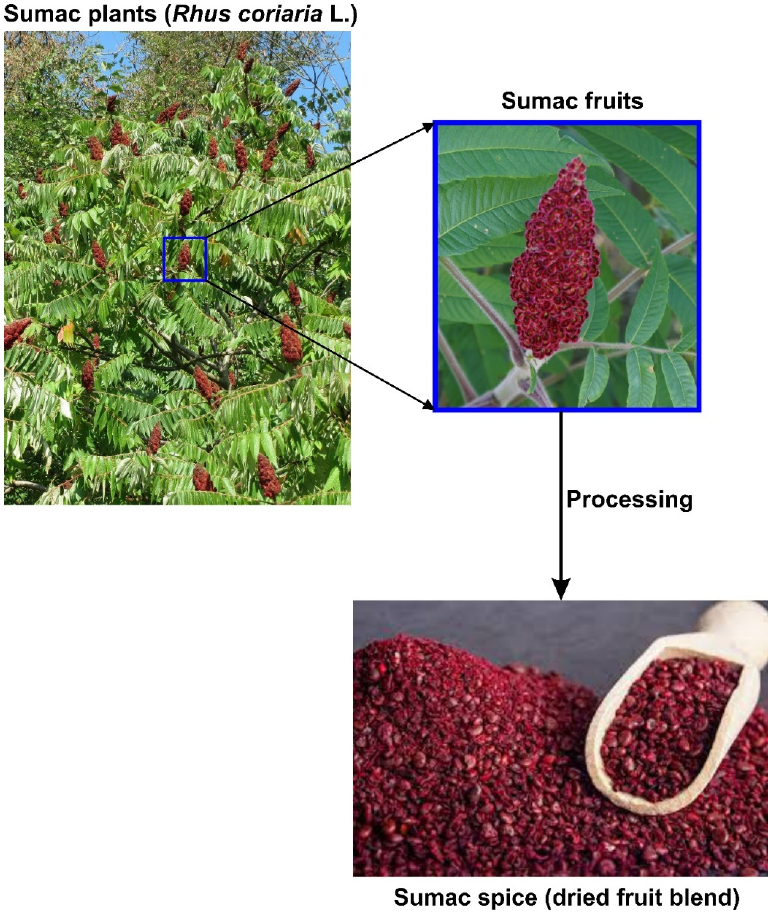
Figure 1. Sumac plants and its spice product.